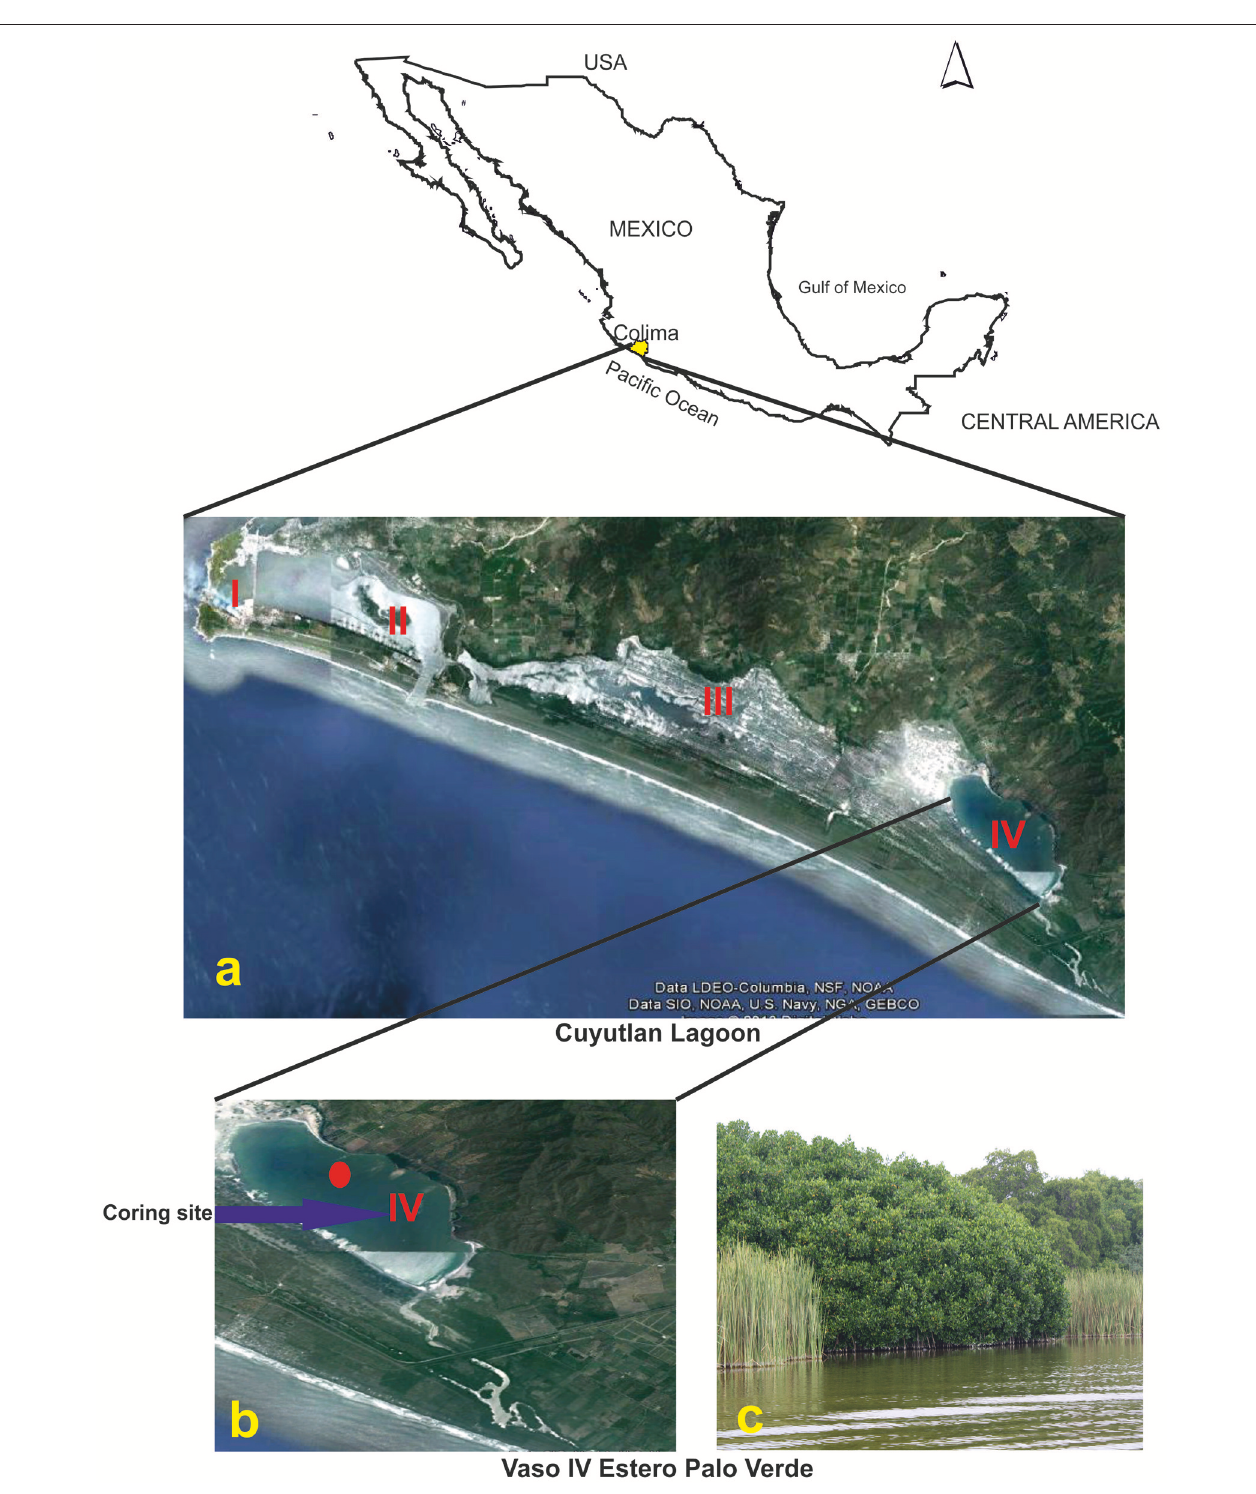
FIGURE 1 | Location of the study area. (A) Cuyutlan Lagoon in the Colima state, Pacific coast of Mexico with “Vaso” I, II, II, and IV; (B) The coring site at “Vaso” IV-Estero Palo Verde; (C) Partial view of Cuyutlan Lagoon and the nearby mangrove forest.